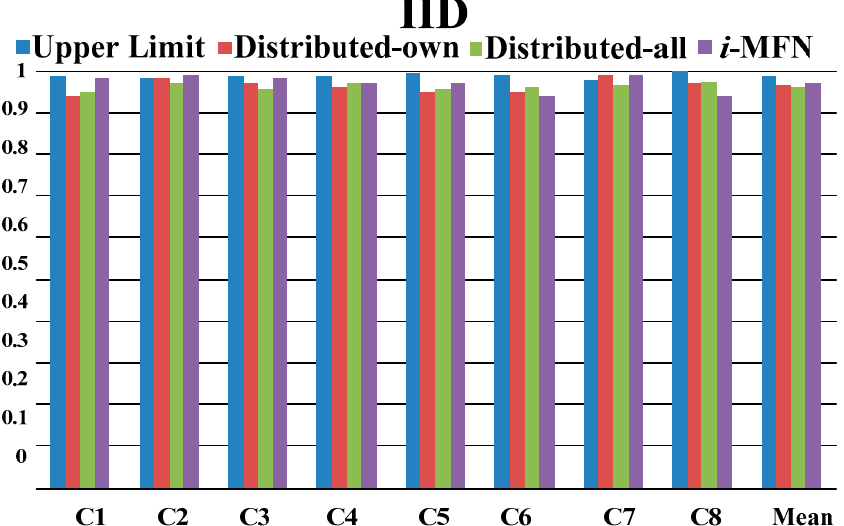
Figure 10. Experimental accuracy comparison under IID data distribution. Table 4. Comparison of diagnostic accuracy under IID distribution